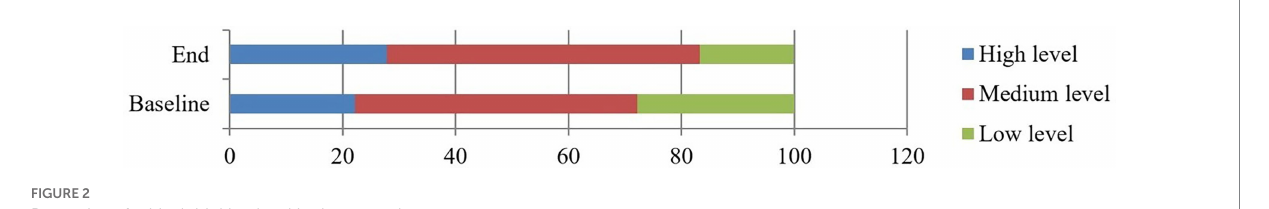
FIGURE 2 Dynamics of critical thinking level in the control